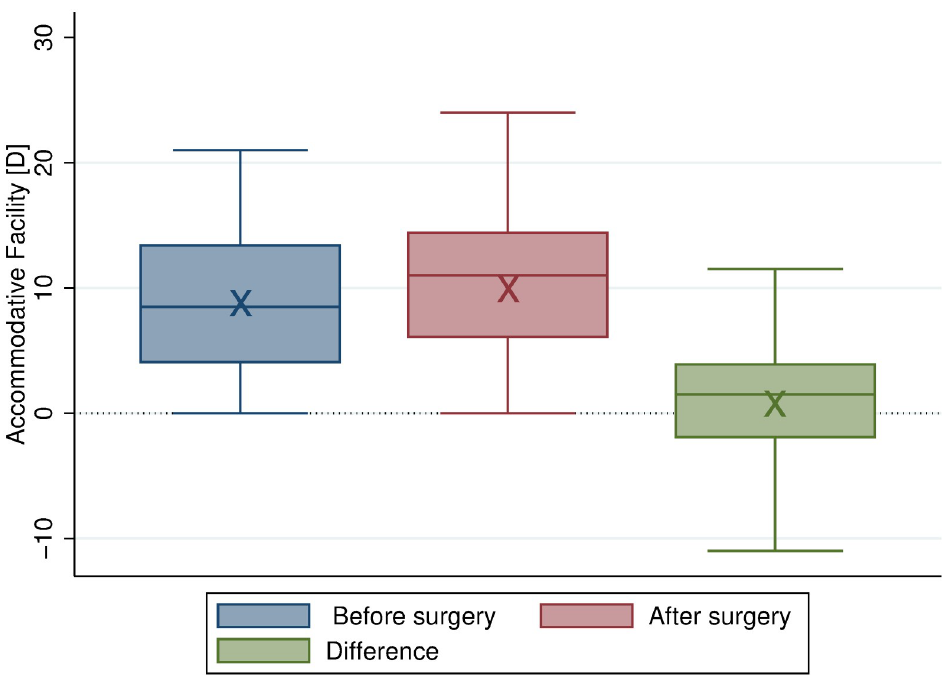
Fig 4. Box plots of the accommodative facility showing no significant change due to surgery. The box indicates the interquartile range, the middle line within the box indicates the median, and the whiskers display the adjacent values (i.e. 1.5 times the interquartile range beyond the 25 th and 75 th percentile). Also, the “x” marks the mean. Red box: Before surgery. Blue box: After surgery. Green box: Surgically induced difference (not statistically significant, P = .21).